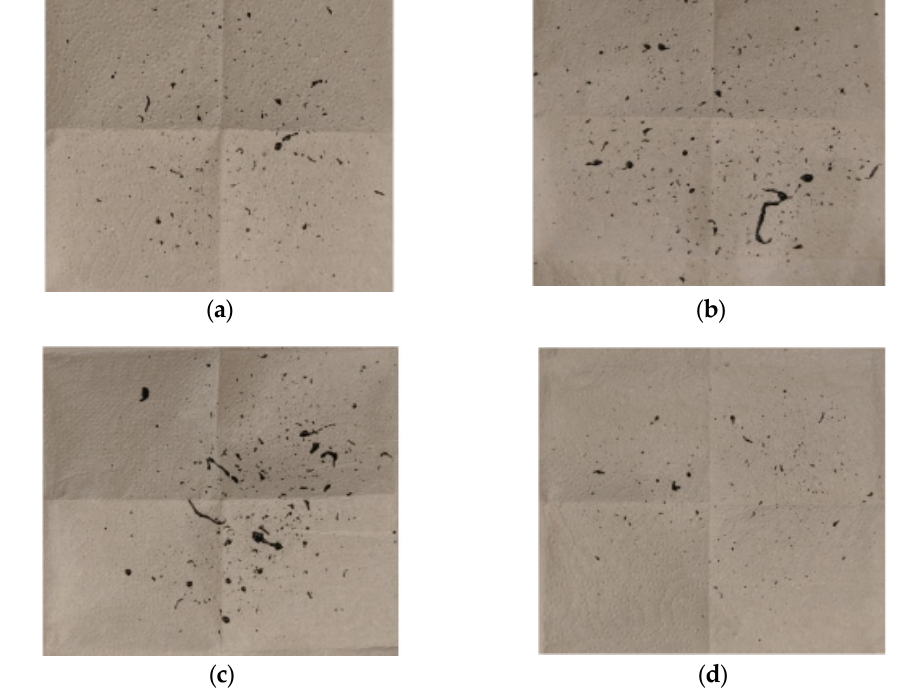
Figure 6. Sample photos of towels above the head for particular test parameters: ( a ) variant 1; ( b )